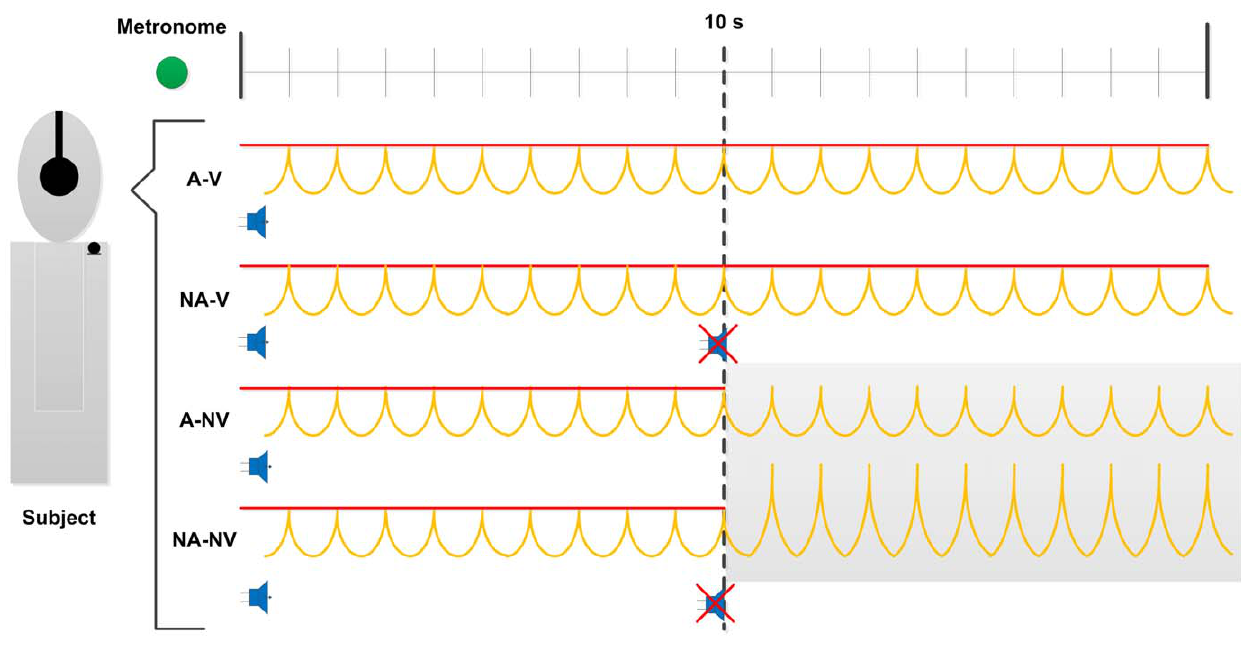
Figure 1. Schematic illustrating the four experimental conditions used in our protocol. Auditory voice feedback either remained present throughout the trial (A), or was replaced with masking noise after 10 s (NA). Similarly, visual feedback of vocal intensity relative to the 80 dB SPL target either remained present throughout the trial (V), or was removed after 10 s (NV). Following feedback manipulations, participants were instructed to make continued responses synchronized with the visual metronome and at the target vocal intensity for the remainder of the trial. We hypothesized that provision of visual reference stimuli would calibrate attenuated somatosensory signals and result in reduced expression of the Lombard effect following removal of auditory voice feedback.